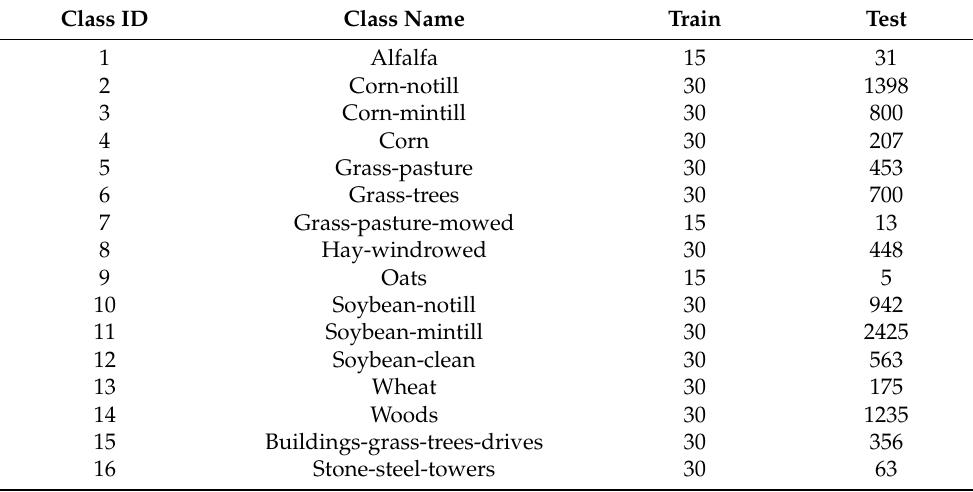
Figure 7. Indian Pines. ( a ) False-color image. ( b ) Ground-truth map. Table 1. Number of training and test sets for the Indian Pians dataset.